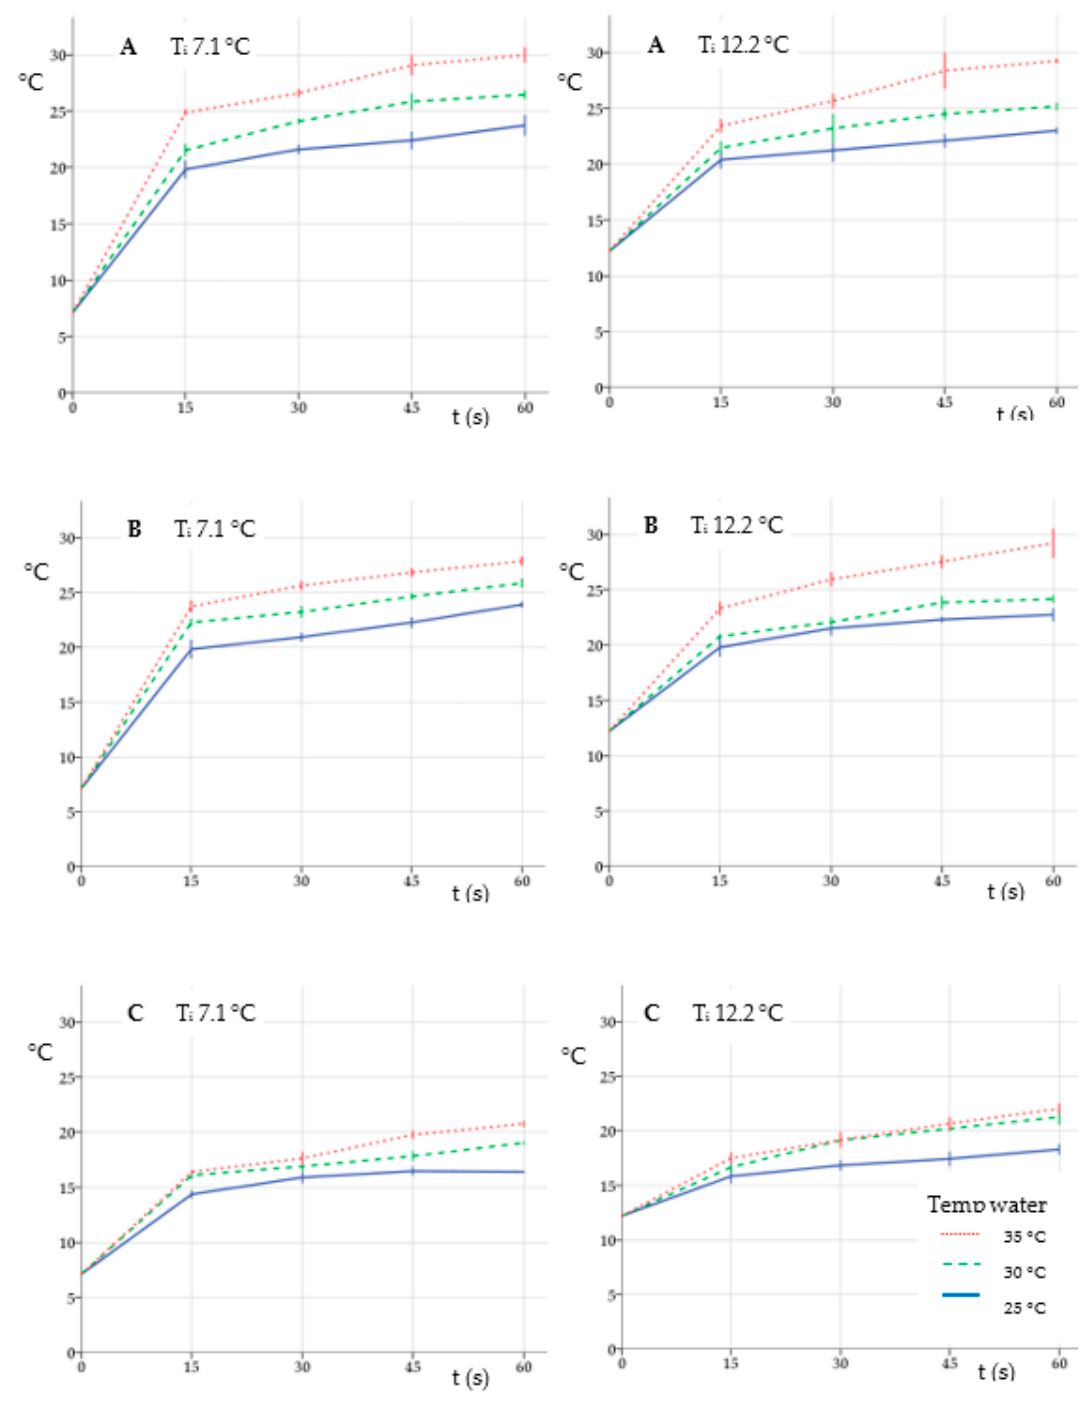
Figure 2. Evolution of the fruit temperature of 3 olive varieties (A: Arbequina; B: Cobrançosa; C: Gordal) at two initial temperatures (Ti) and immersed in moving water at different temperatures. Vertical bars express mean ± SD.